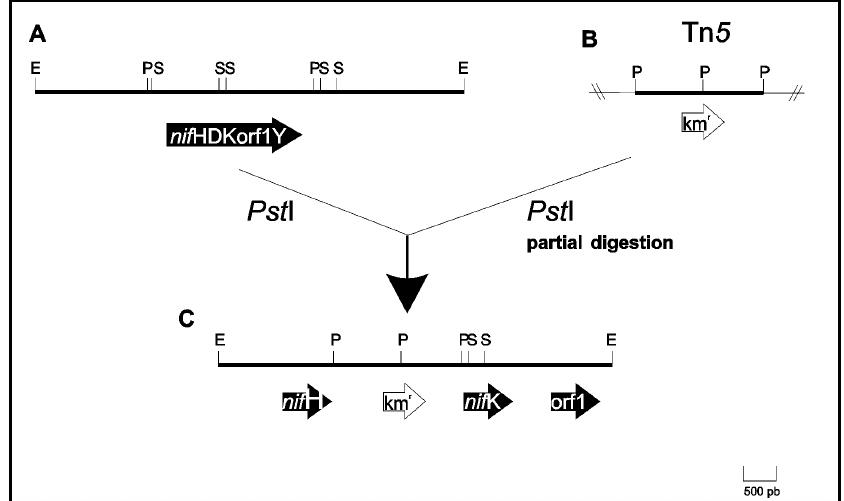
Figure 1 - Strategy for constructing the gene replacement cartridge. A) Physical map of the Azospirillum brasilense nif structural gene clus- ter. B) Partial physical map of the Tn 5 transposon. C) Physical map of the pKm6 plasmid containing the nif D gene replaced with the km r